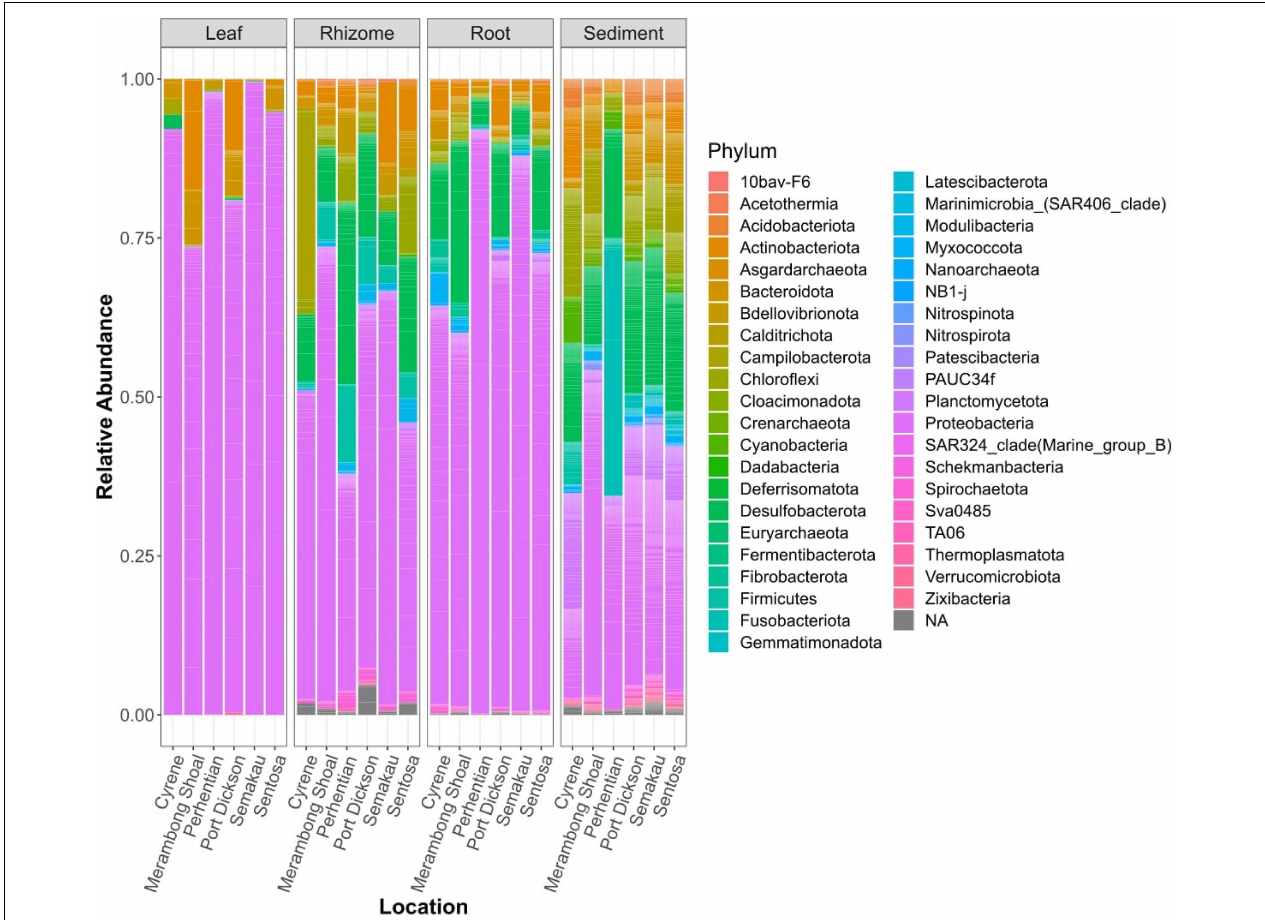
FIGURE 4 | Stacked bar plots of relative bacterial abundance. All samples of a specific type, from one location